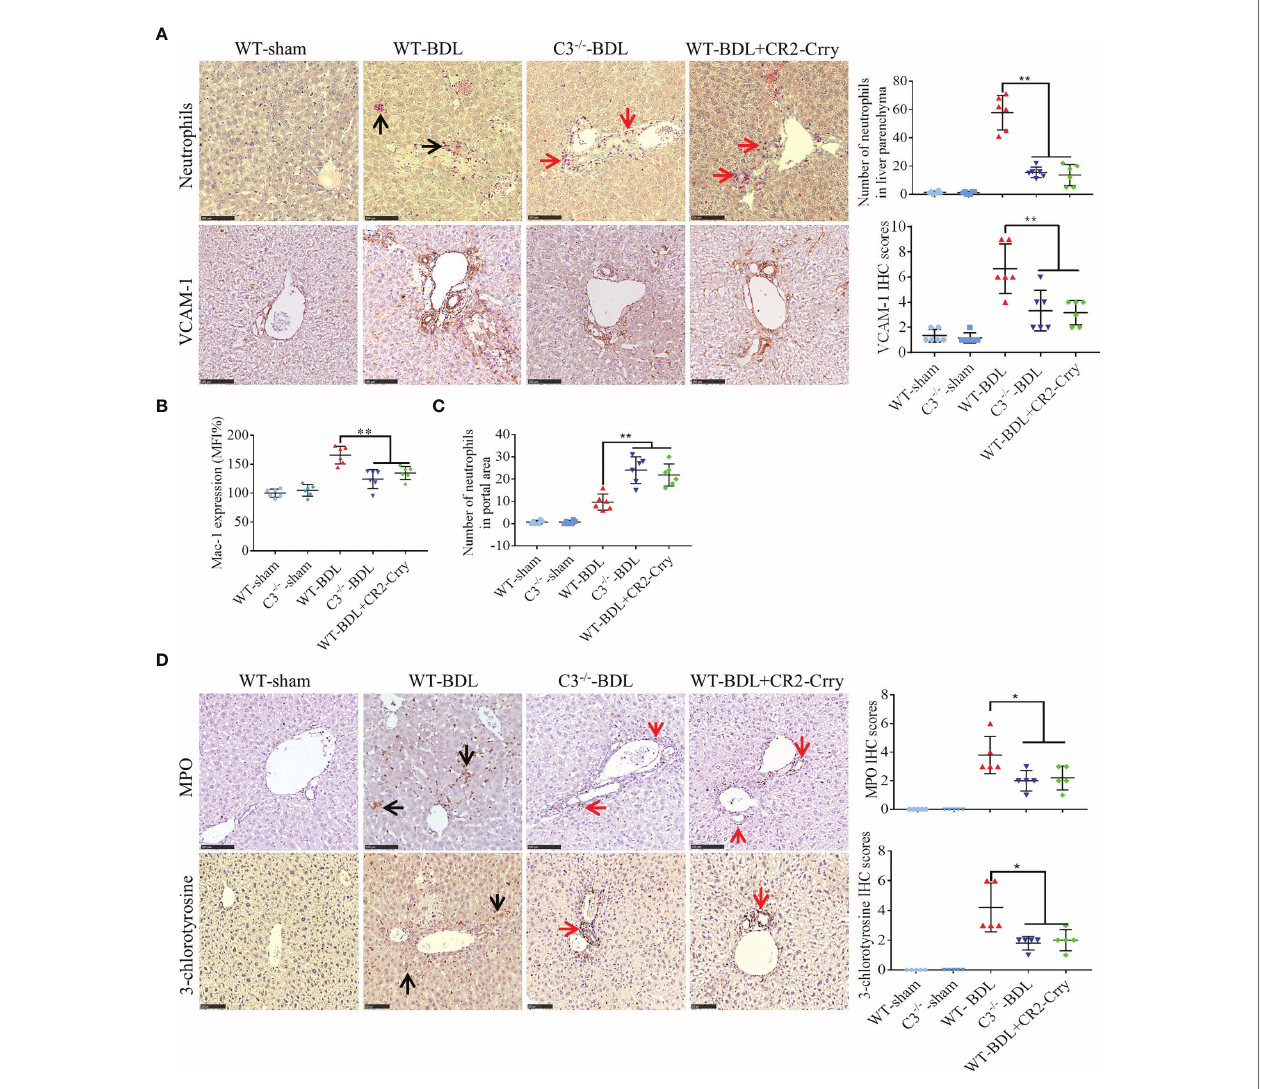
FIGURE 3 | C3 de fi ciency or CR2-Crry signi fi cantly inhibits the activation of neutrophils and decreases the expression of VCAM-1 and Mac-1 in mice with CLI. Wild- type and C3 de fi cient mice were subjected to BDL or sham operations. WT-BDL mice were injected i.p. with PBS or CR2-Crry and sacri fi ced 3 days later. Formalin- fi xed, paraf fi n-embedded liver sections were stained for speci fi c esterase or immunostained for MPO, 3-chlorotyrosine and VCAM-1. Anticoagulated blood was subjected to fl ow cytometry for Mac-1 detection. (A) Speci fi c esterase staining for neutrophils and immunohistochemical staining for VCAM-1 in liver parenchyma. (B) Expression of Mac-1 on neutrophils. (C) Assessment of neutrophils in the liver portal area. (D) Immunohistochemical staining for MPO and 3-chlorotyrosine. Scale bars for all, 100 m m; n = 5 – 6 per group. Black arrows, positive staining in the liver parenchyma; red arrows, positive staining in the portal area. Results are expressed as mean ± SD. *p < 0.05, **p < 0.01; NS, not signi fi